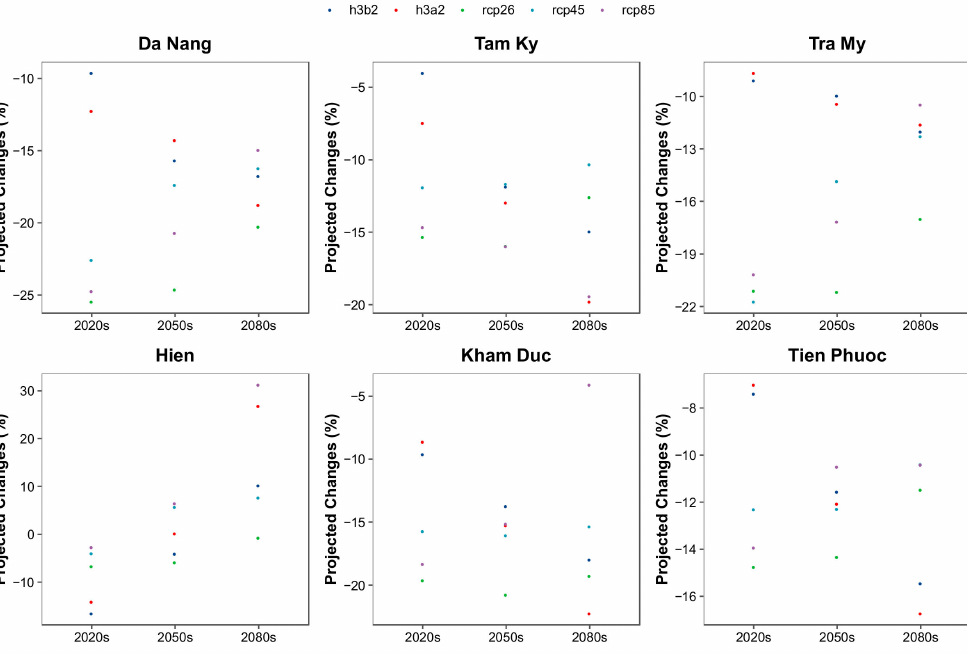
Figure 7. Projected changes in average annual rainfall in the 2020s, 2050s, and 2080s under scenarios B2, A2 (HadCM3), and RCP2.5, 4.5, 8.5